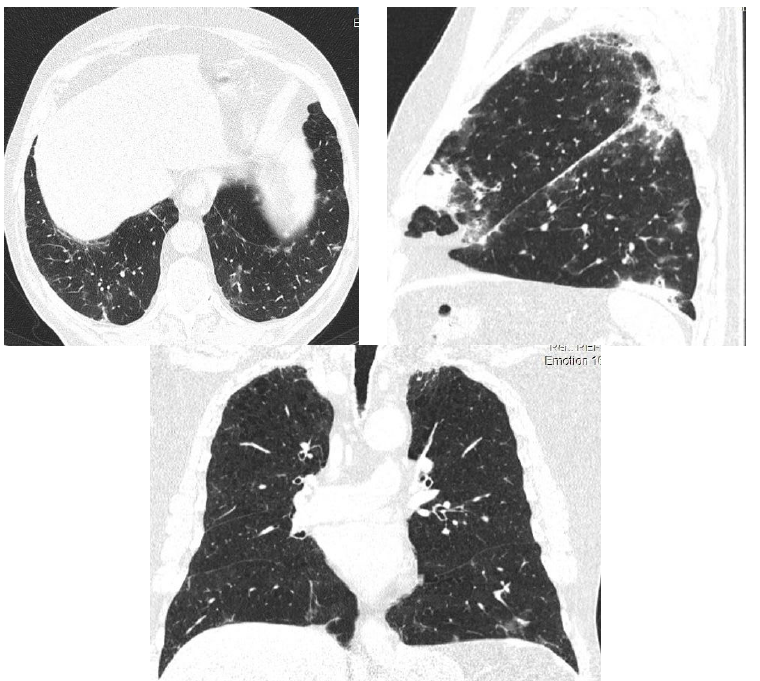
Figure 2. HRCT—July 2019—Case 1. Subpleural honeycombing, nodular lesions, linear fibrosis, traction bronchiectasis, reticulation and ground glass opacities with associated minimal emphy- sema. Diffuse pulmonary infiltrates in the inferior half.